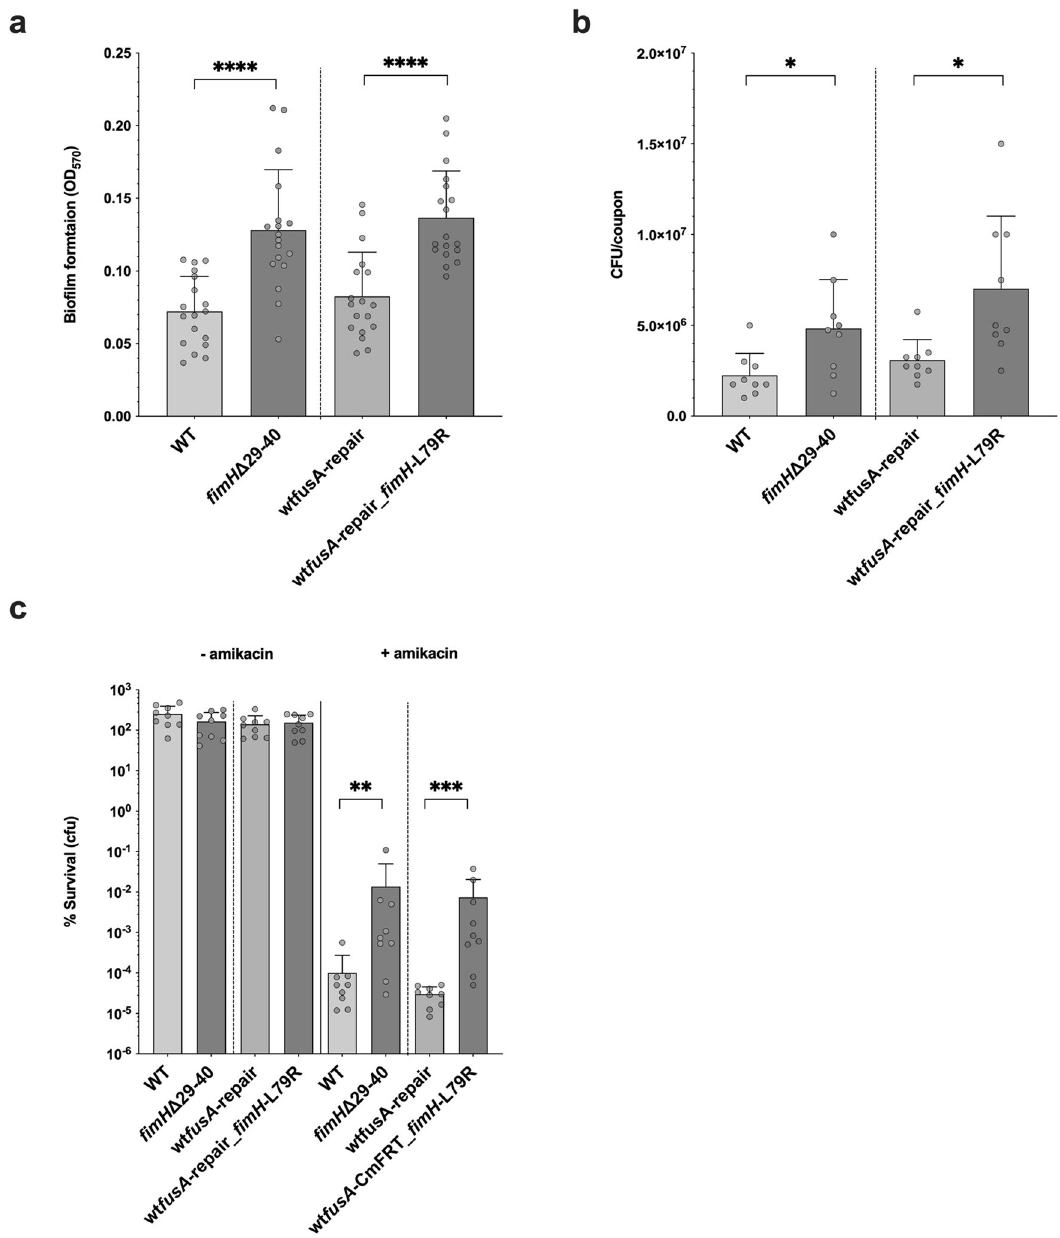
Fig. 7 fi mH mutants display higher capacity to form bio fi lms and enhanced tolerance towards a lethal concentration of amikacin. a , b Bio fi lm amounts ( a ) and colony forming units ( b ) of fi mH mutants formed on silicone coupons for 24 h. c The survival rate of bio fi lm cells of fi mH mutants on silicone coupons after the treatment with 80xMIC of AMK. It was calculated by using the formula 100x(CFU AFTER /CFU BEFORE ), where CFU BEFORE corresponds to CFU/coupon before treatment and CFU AFTER to CFU/coupon after treatment. The data corresponded to n = 18 biological replicates for a, and n = 9 for b and c . Data are represented as the mean ± SD. Statistics correspond to unpaired two tailed t -test with Welch ’ s correction comparing each fi mH mutant to its corresponding wt isogenic strain. * p < 0.05; ** p < 0.01; *** p < 0.001, **** p < 0.0001. In c , statistics were performed on log-transformed % survival. fi mH Δ 29-40 in frame deletion is present in clone 239 that differs from the ancestral strain by this single mutation. We showed previously that the exact same fi mH Δ 29-40 deletion enhanced bio fi lm formation in E. coli K12 50 (see supplementary Data 4). The clone with the mutation fi mH L79R was created after de-construction of the fusA G604V mutation from the clone 219 where we replaced the fusA G604V allele by a wt version of fusA (wt fusA -repair) (see Methods). This clone also codes for a synonymous mutation I255I in the gene LF82_RS22000